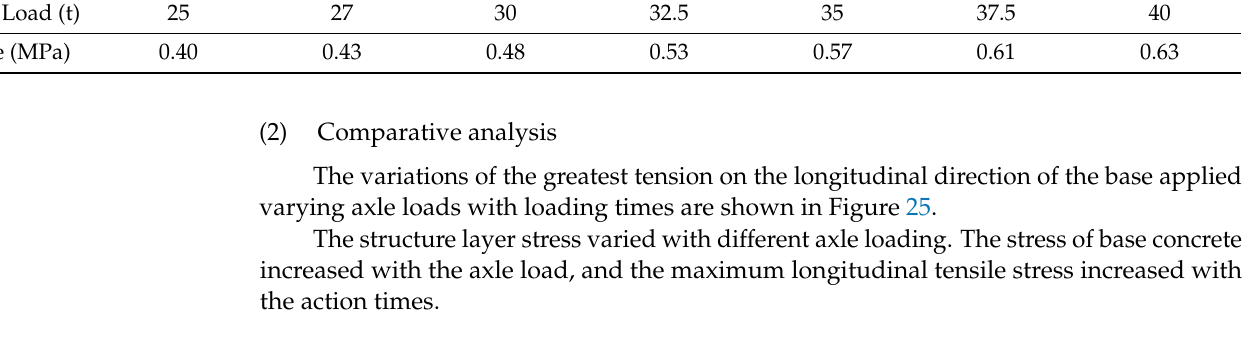
Figure 20. Stress distribution diagram of the base plate under 15 million applications of fatigue load